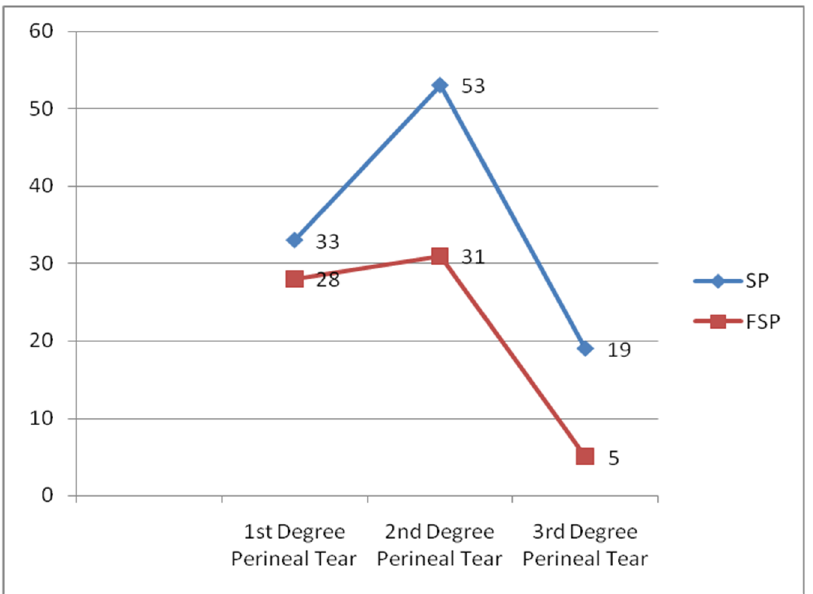
Figure 3. Number of the study participants with degrees of perineal tear compared between the intervention and the control group, in Amhara public Health facilities, 2019.